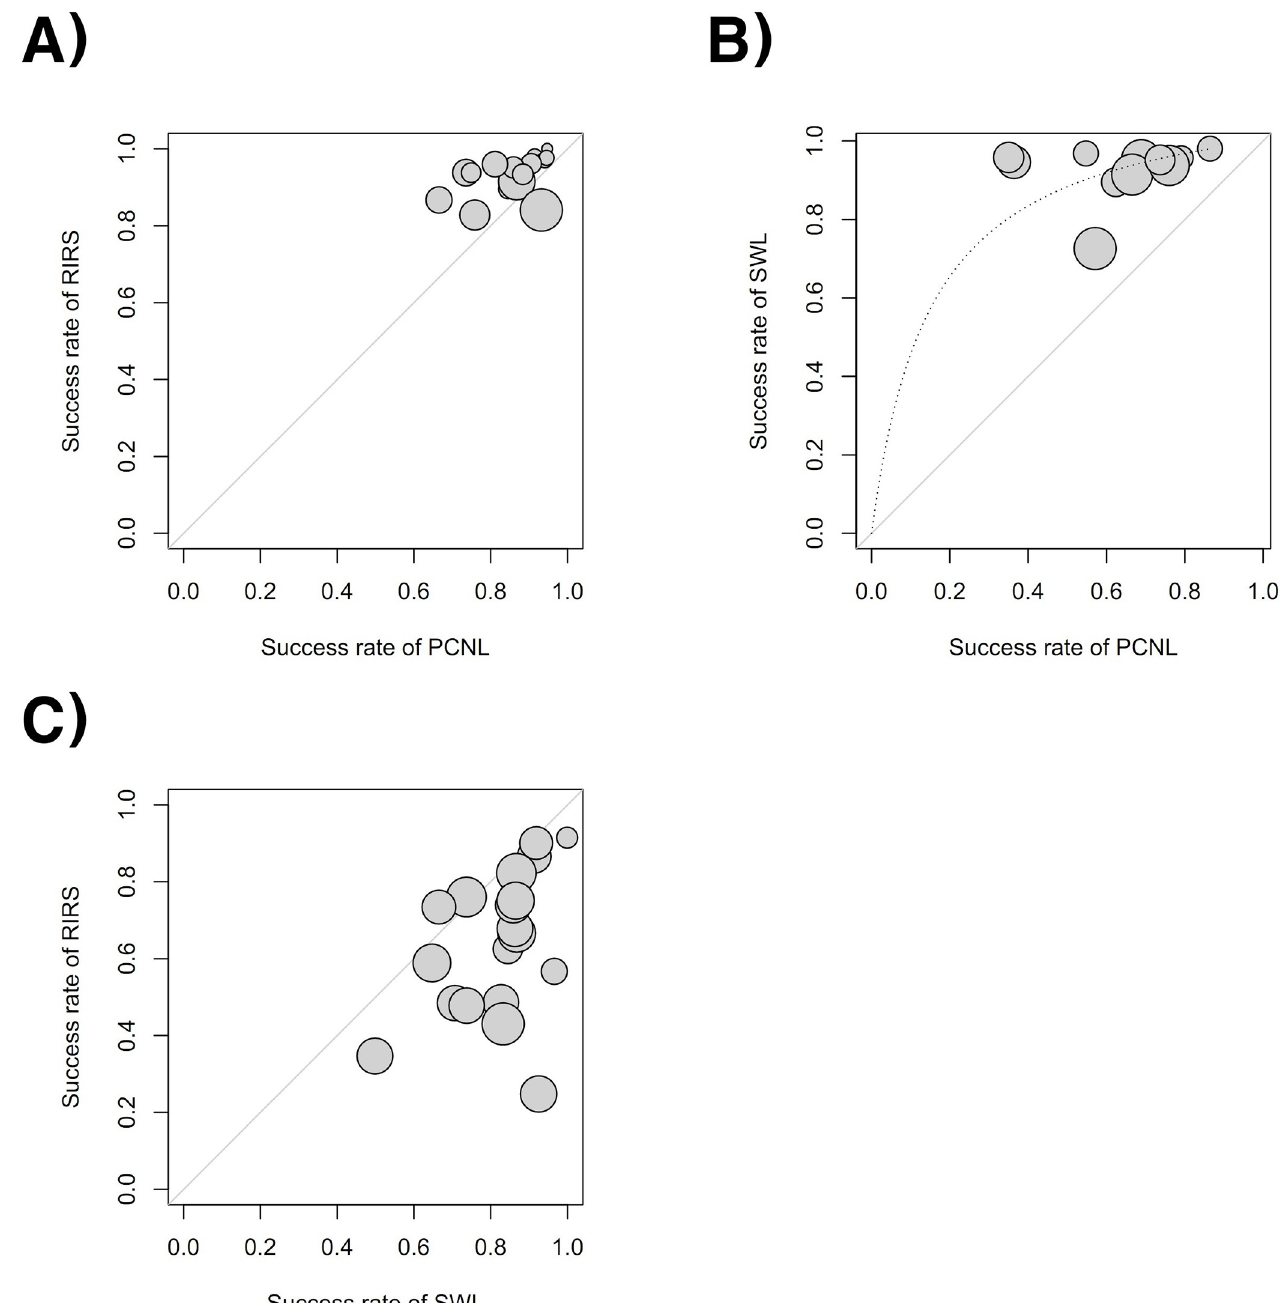
Fig 6. L’Abbe plots of success rate between RIRS and PCNL (A), SWL and PCNL (B) and RIRS and SWL (C). Little heterogeneity was noted in L’Abbe plots.